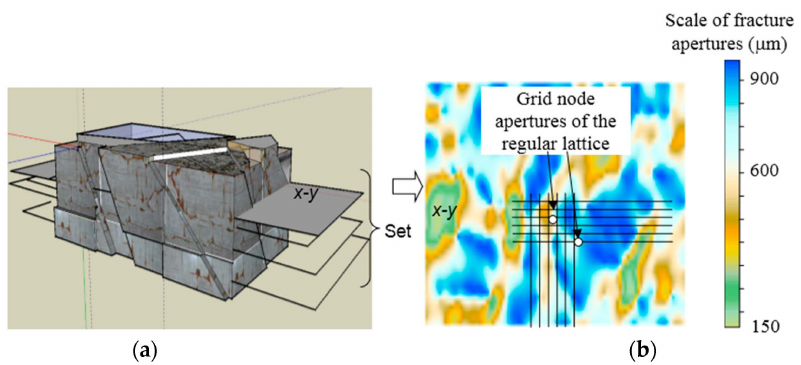
Figure 1. ( a ) Parallel set of horizontal ( x-y ) fractures with permeability equivalent to the real fractured medium; ( b ) modeled fracture apertures in each single fracture of the set: the aperture variation in the x-y plane is obtained by means of the experimental variogram derived from results of well pumping (or injection) tests.